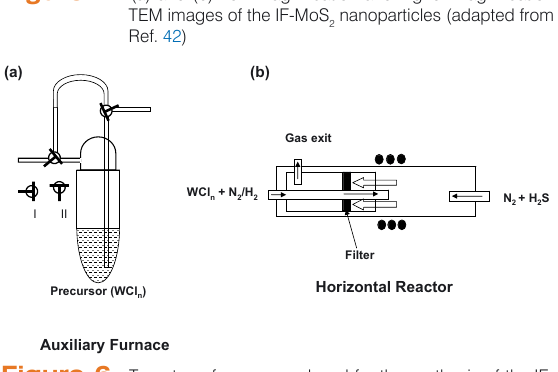
Figure 6. Two-stage furnace employed for the synthesis of the IF- WS nanoparticles and nanotubes. This set-up includes 2 the horizontal reactor (b) and the auxiliary reactor (a) which produces the WCl vapors (I- bypass actuated n {flushing with inert gas}; II- reaction working conditions) (adapted from Ref.